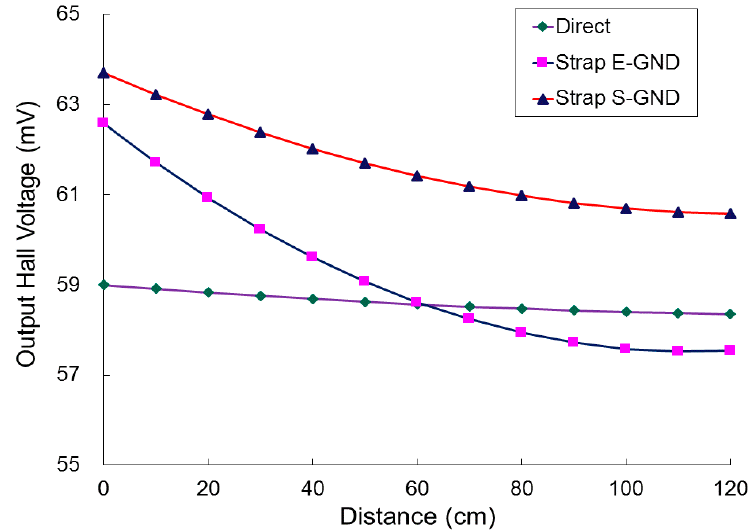
Figure 13. Measured output Hall voltages as a function of the distance, from 0 to 120 cm in steps of 10 cm, at a bias current of 12 mA for the proposed strip MAGFET with readout circuit and IA PCB (INA333).